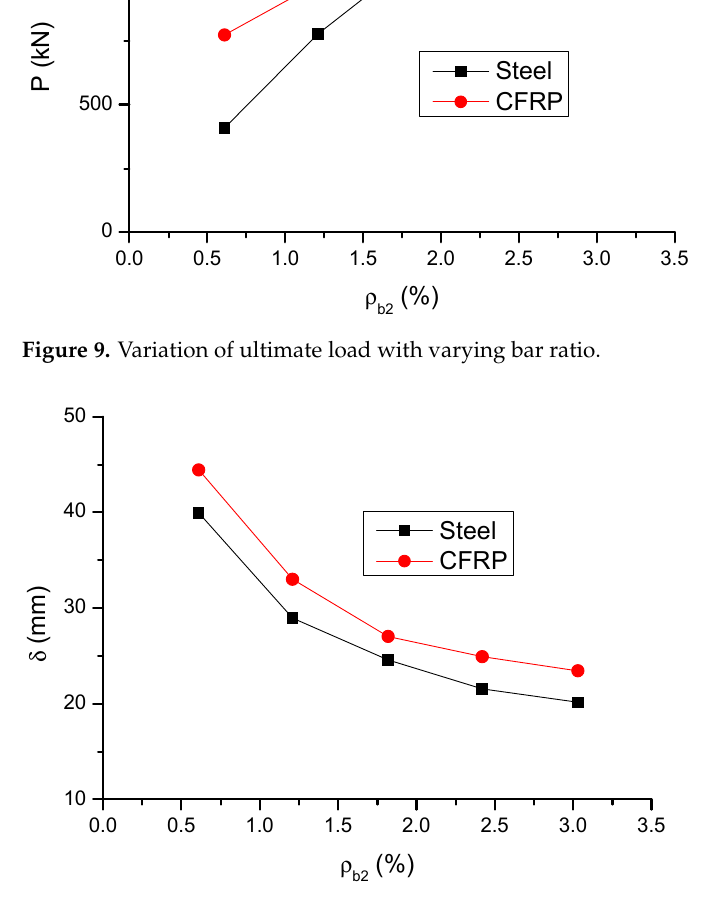
Figure 10. Variation of ultimate deflection with varying bar ratio.